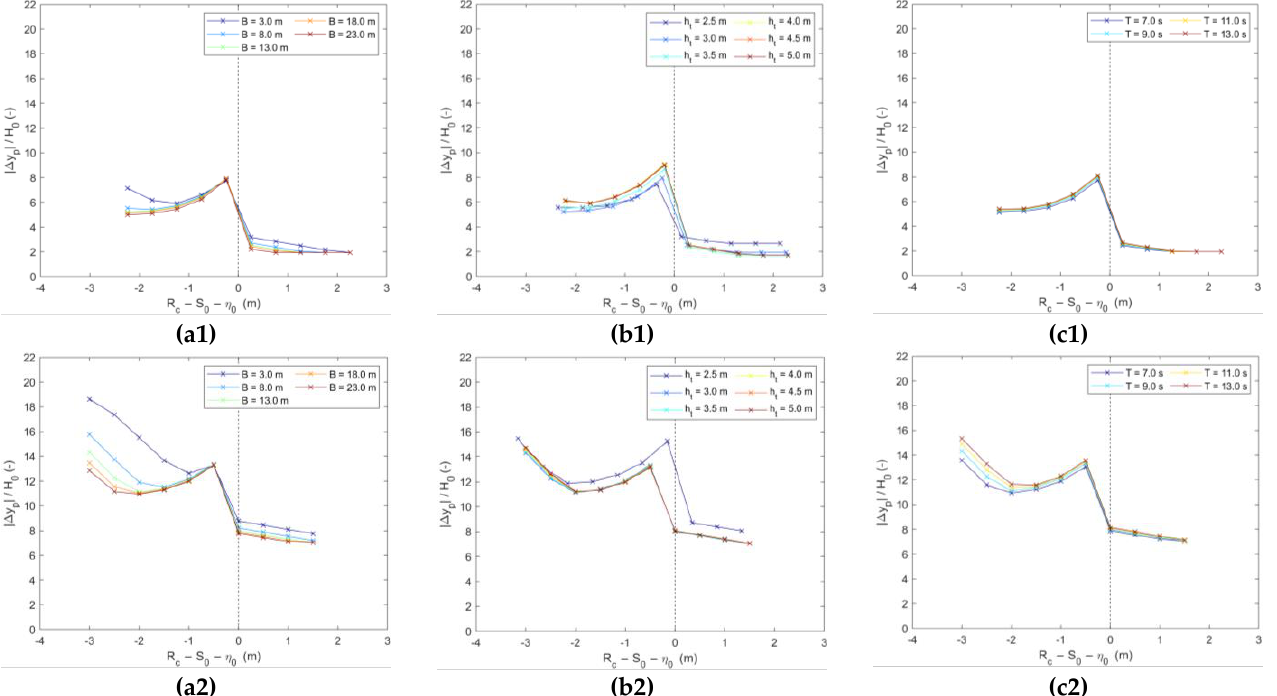
Figure 9. Relative shoreline recession ( Δ y p /H 0 ) for beaches protected by breakwaters for 2 different values of sea level rise: ( a1 ), ( b1 ) and c1 for S 0 = 0.2 m; ( a2 ), ( b2 ) and ( c2 ) for S 0 = 1.0 m. ( a1 ), ( a2 ) values of sea level rise: ( a1 – c1 ) for S 0 = 0.2 m; ( a2 – c2 ) for S 0 = 1.0 m. ( a1 , a2 ) dependence from B , dependence from B , constant values: H 0 = 3 m, h t = 3 m, T = 9 s, m = 1/20. ( b1 ), ( b2 ) dependence from constant values: H 0 = 3 m, h t = 3 m, T = 9 s, m = 1/20. ( b1 , b2 ) dependence from h t , constant values: h t , constant values: H 0 = 3 m, B = 13 m, T = 9 s, m = 1/20. ( c1 ), ( c2 ) dependence from T , constant values: H 0 = 3 m, B = 13 m, T = 9 s, m = 1/20. ( c1 , c2 ) dependence from T , constant values: H 0 = 3 m, B = 13